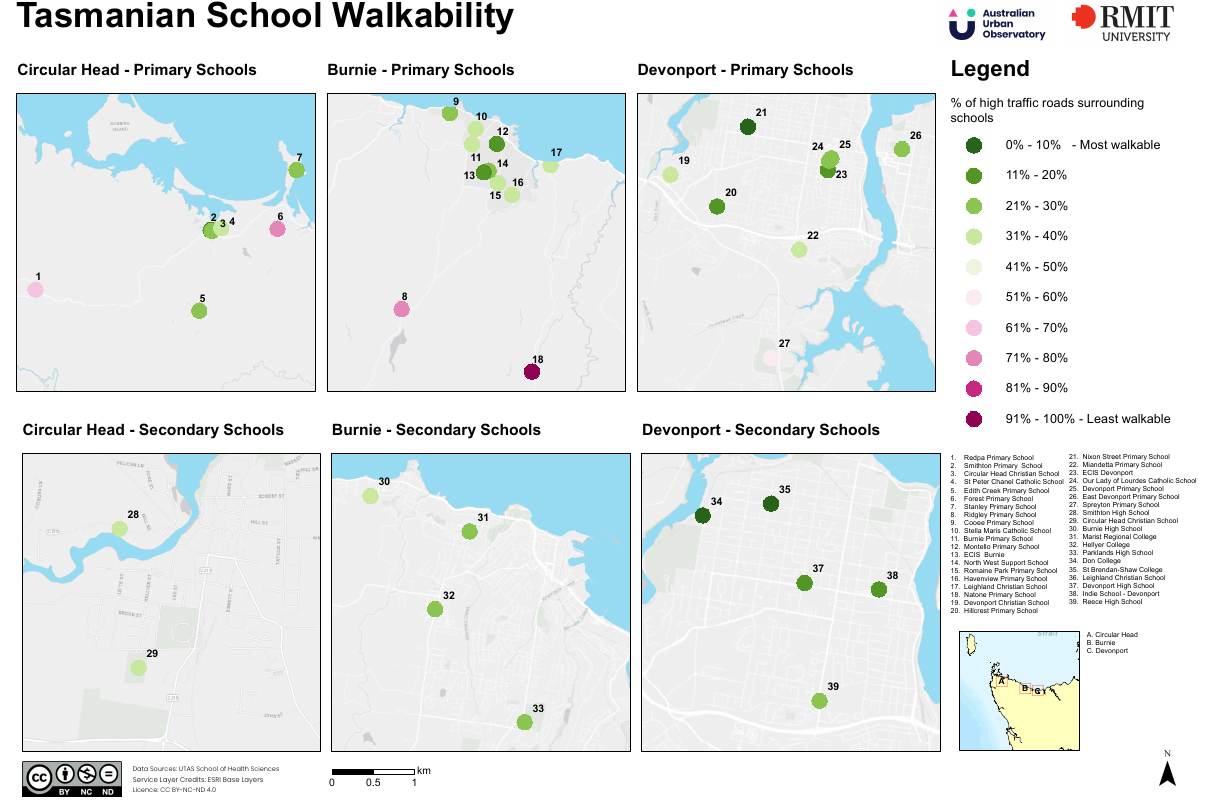
Figure 2. Walkability around primary and secondary schools.